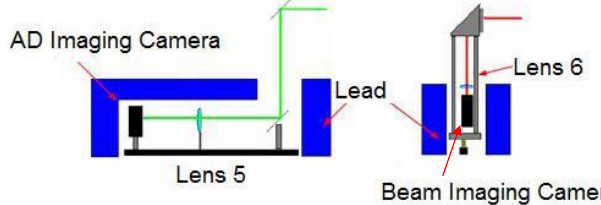
FIG. 3. (Color) Side view of light paths to cameras; top rays are outputs from the breadboard optics shown in Fig. 2.